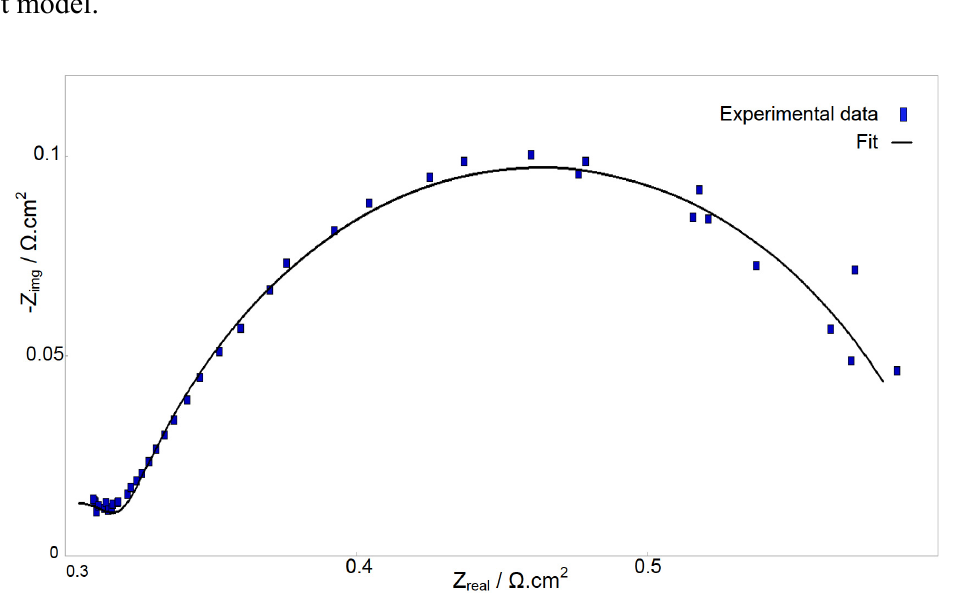
Figure 3. Fitting between measured impedance data and the chosen equivalent circuit